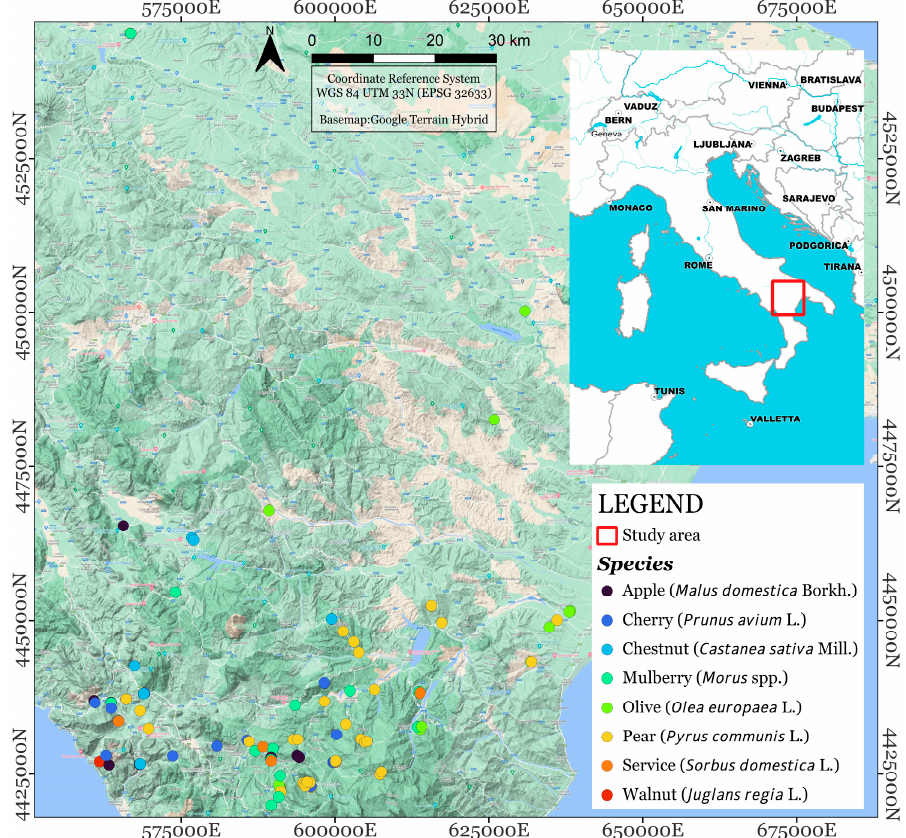
Figure 1. Distribution map of fruit tree sites (color-coded) included in this study. Basemap credit: Google Terrain Hybrid 2023; national boundaries are provided by Natural Earth (https://www.naturalearthdata.com/, accessed on 20 January 2023).